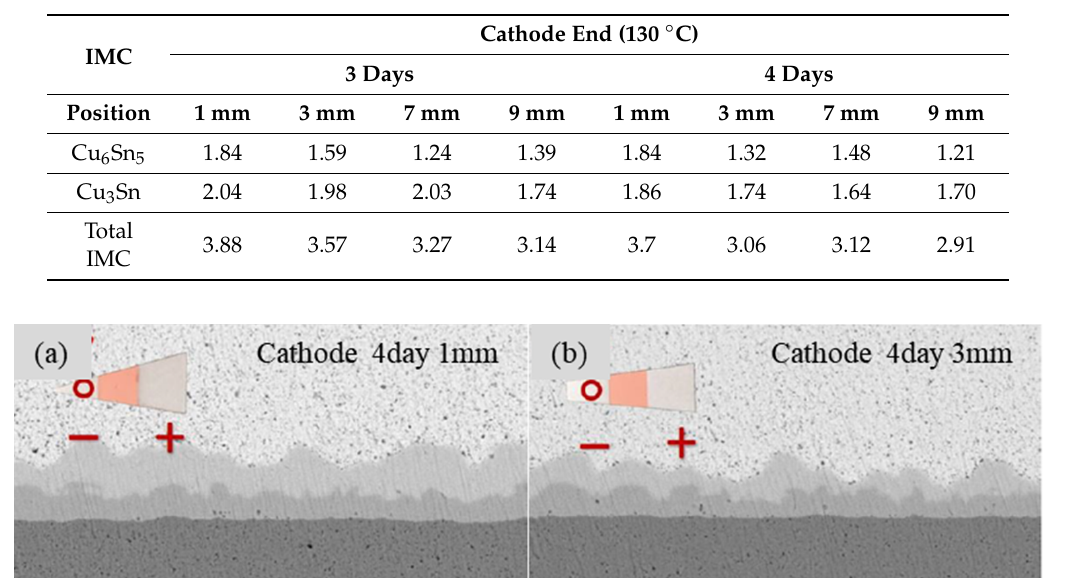
Table 6. The IMC formation and their corresponding thickness in the cathode end of the sample heated at 130 ◦ C and subjected to a current of 0.8 A.